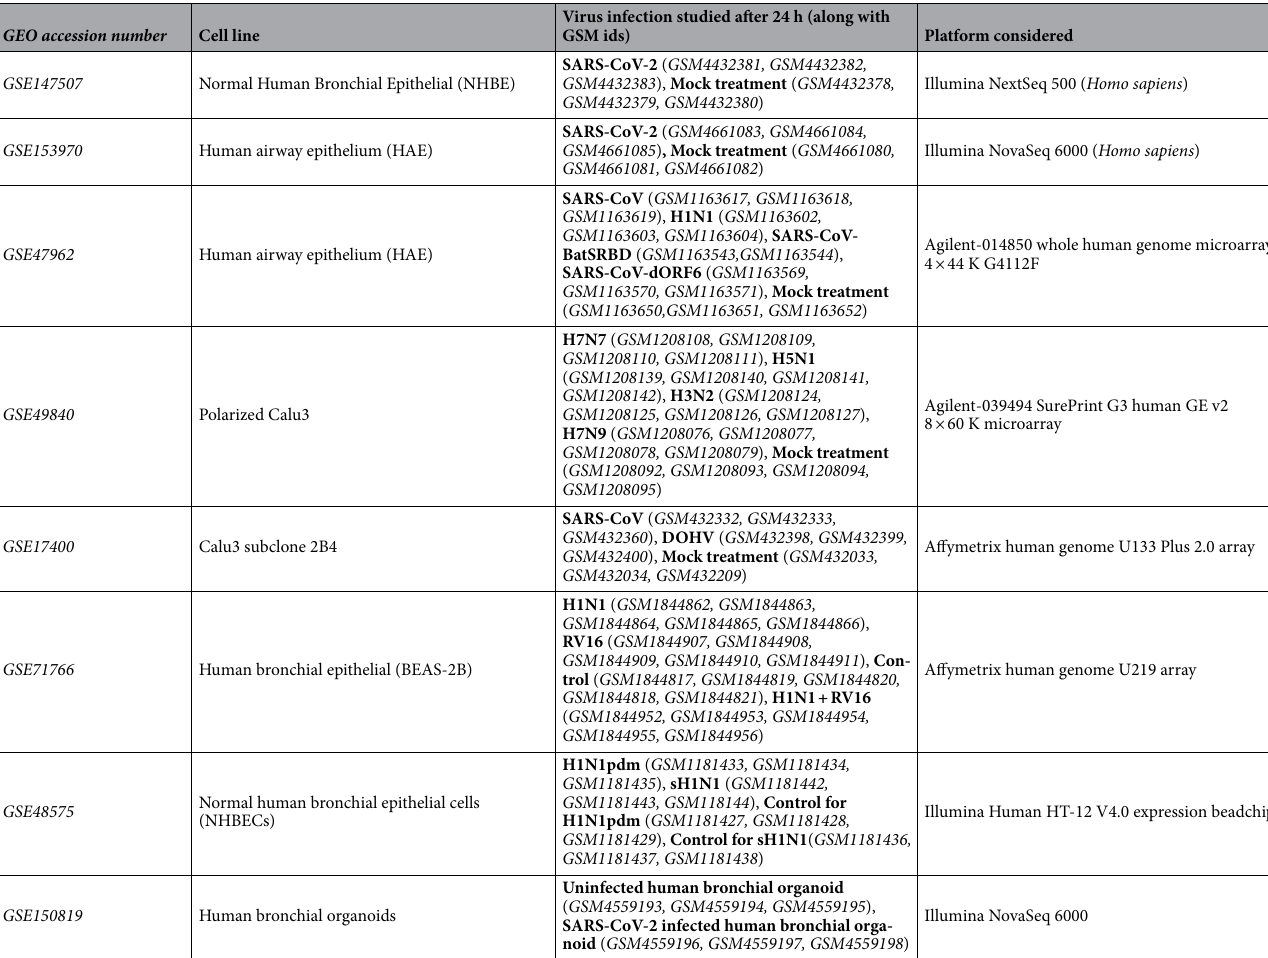
Table 3. Summary of publicly available, high-throughput experimental data considered in the current